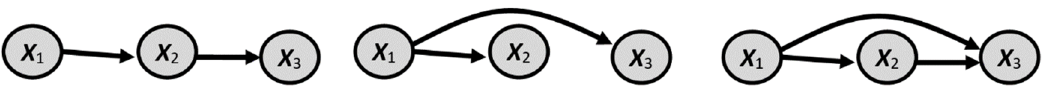
Figure 2. Three structures included in the order < X 1 , X 2 , X 3 >.